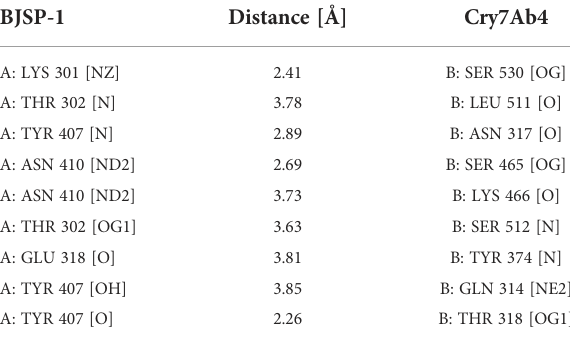
TABLE 3 Hydrogen bonds between BJSP-1 and Cry7Ab4 from the molecular docking model.